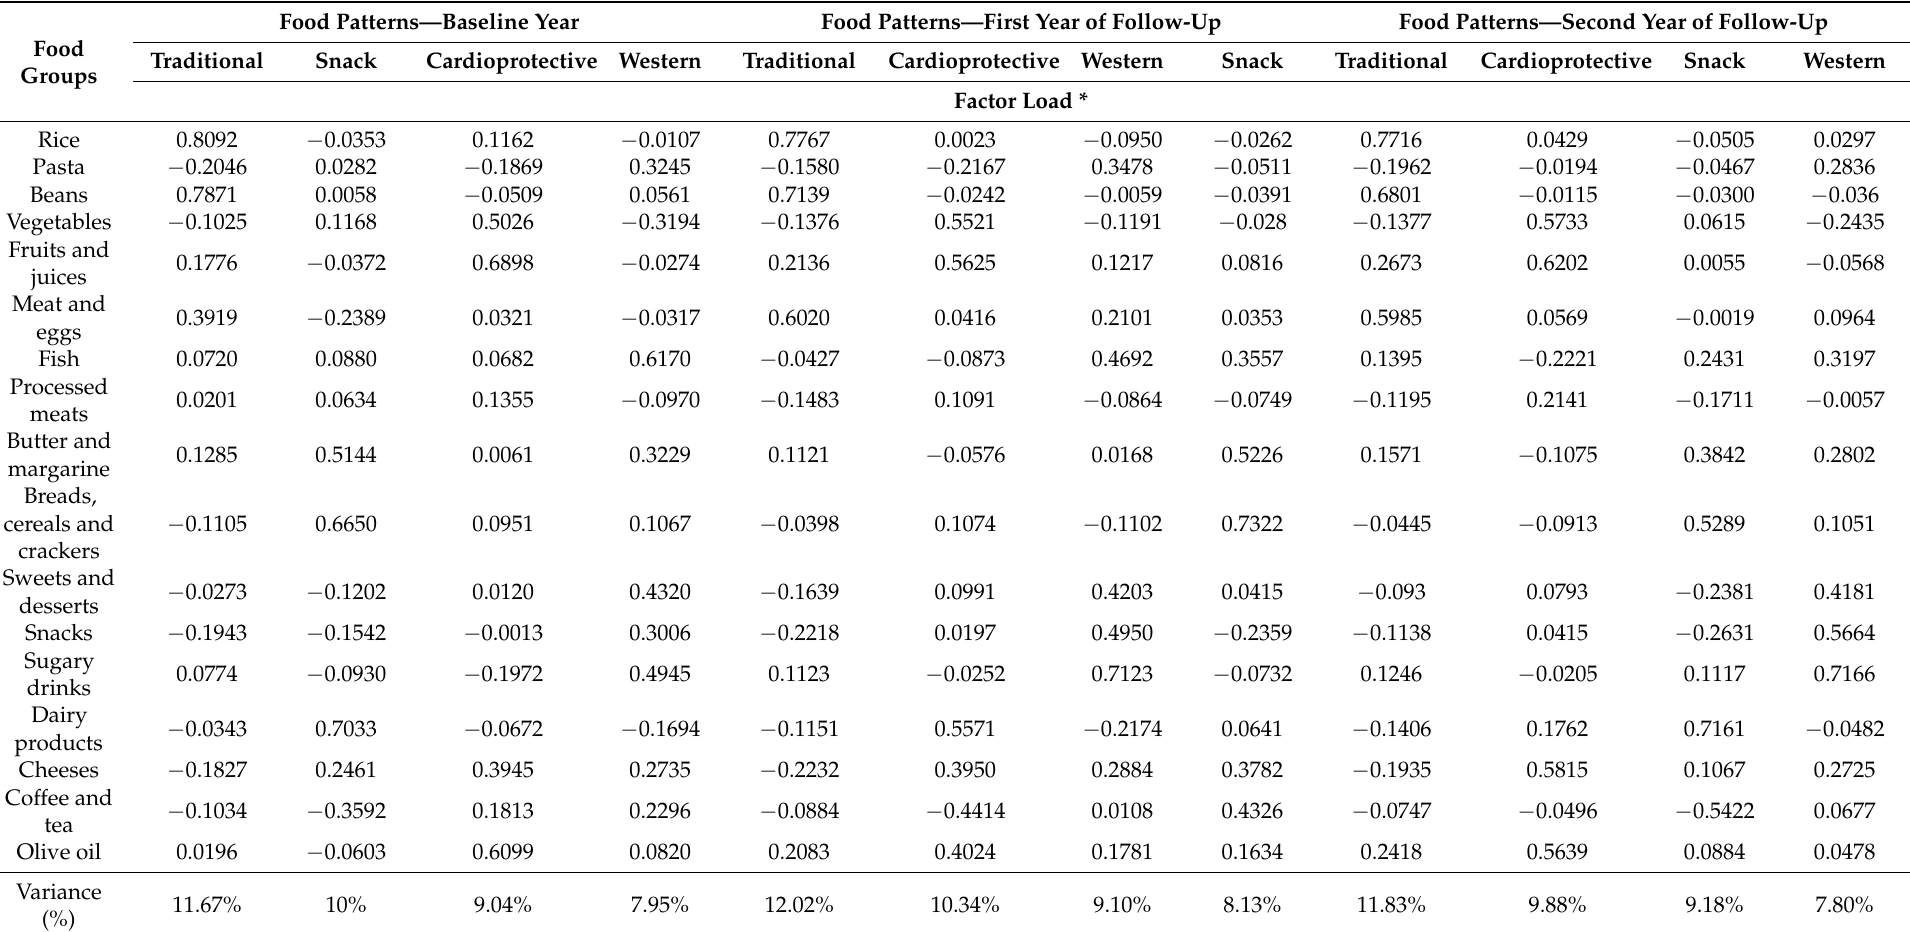
Table 4. Food patterns and factor loads of food groups extracted from the factor analysis with the principal component extraction method for individuals of the BALANCE program’s control group.